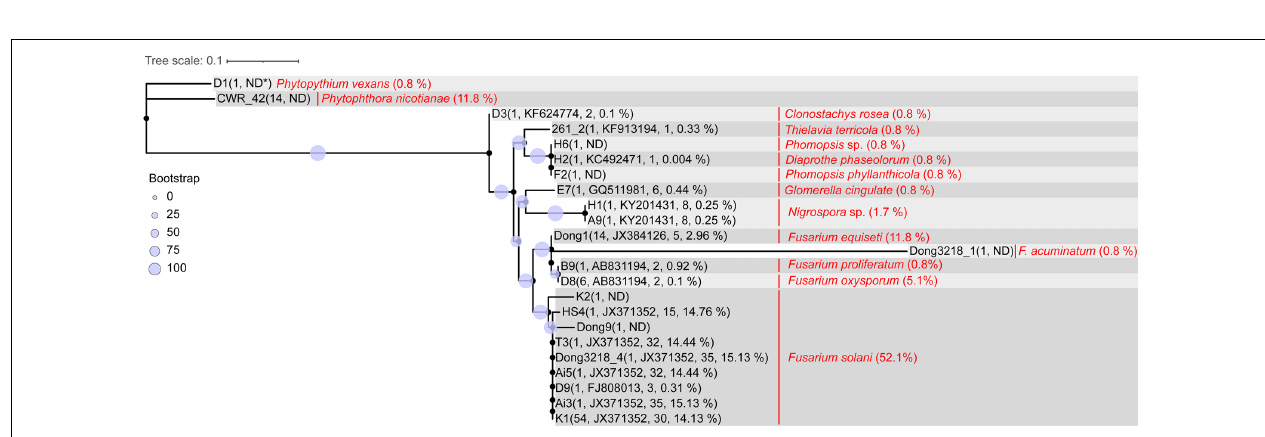
FIGURE 2 | Statistical analysis and summary of bacterial and fungal communities in diseased and healthy roselle rhizosphere soils. Rhizosphere soil samples of healthy ( n = 10) and wilted ( n = 10) roselle plants were collected from three fields and a total of 60 samples were analyzed. (A) Shannon diversity of bacterial community. (B) Shannon diversity of fungal community. (C) nMDS analysis of bacterial OTUs. (D) nMDS analysis of fungal OTUs. (E) Bacterial and fungal community composition of the 10 most abundant classes on average. (F) The abundance distribution of fungal OTU_JX371352 across sampling fields. Field status, “D” for diseased and “H” for healthy.